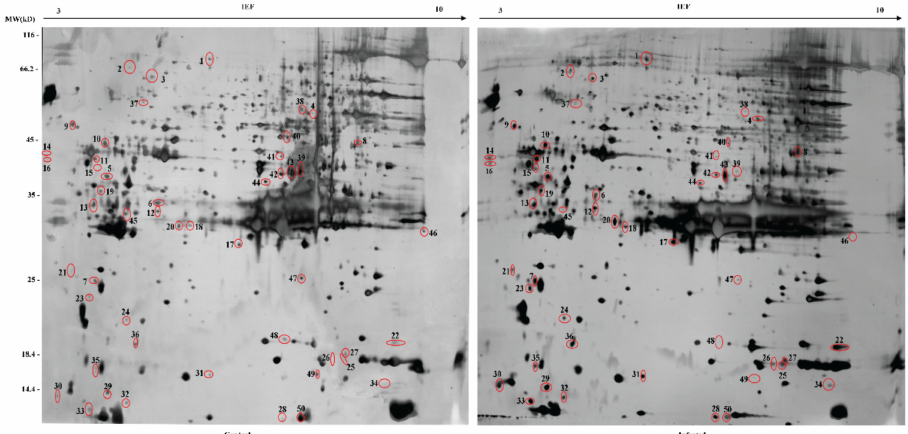
Figure 1. Two-dimensional gel electrophoresis (2-DE) maps of the control and infected hemolymph collected from day-1 female silkworm pupae: The di ff erentially expressed proteins (DEPs) are indicated by circles and numeric labels, which correspond to the numbers presented in Table 1. All samples were processed in